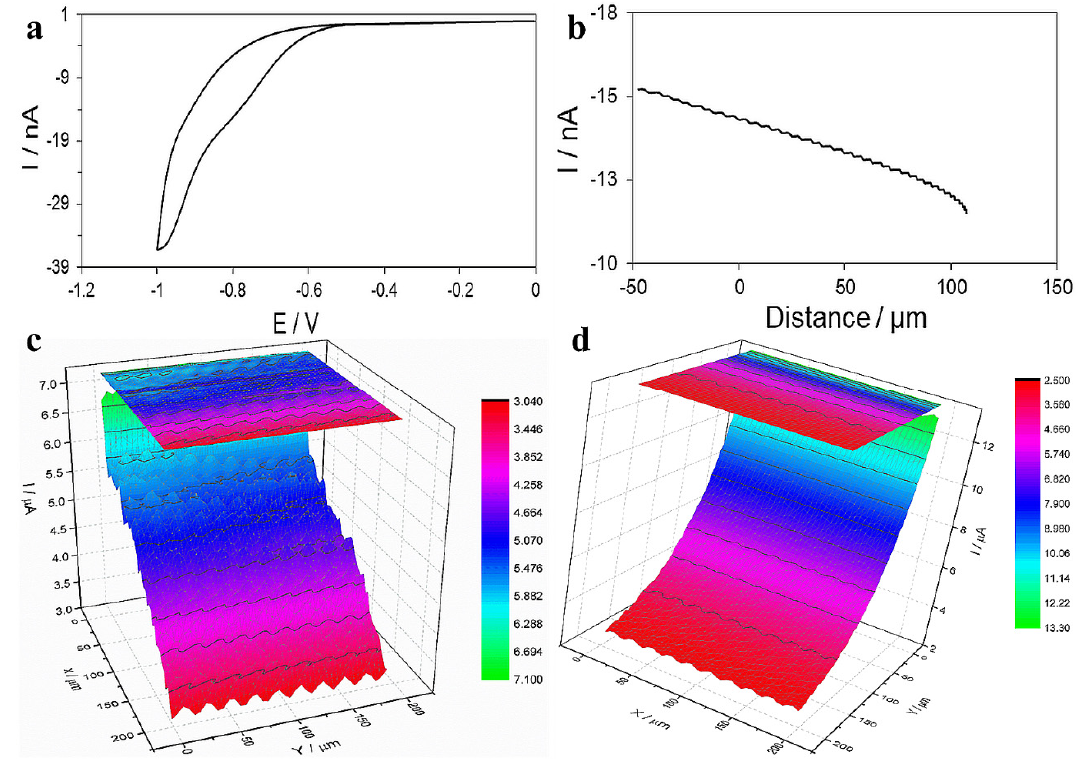
Figure 7. ( a ) dissolved oxygen reduction; ( b ) drop down percentage of probe; ( c ) represents high oxygen consumption by the bacteria and a decrease in the magnitude; ( d ) increased magnitude due to the absence (death) of bacterial population.